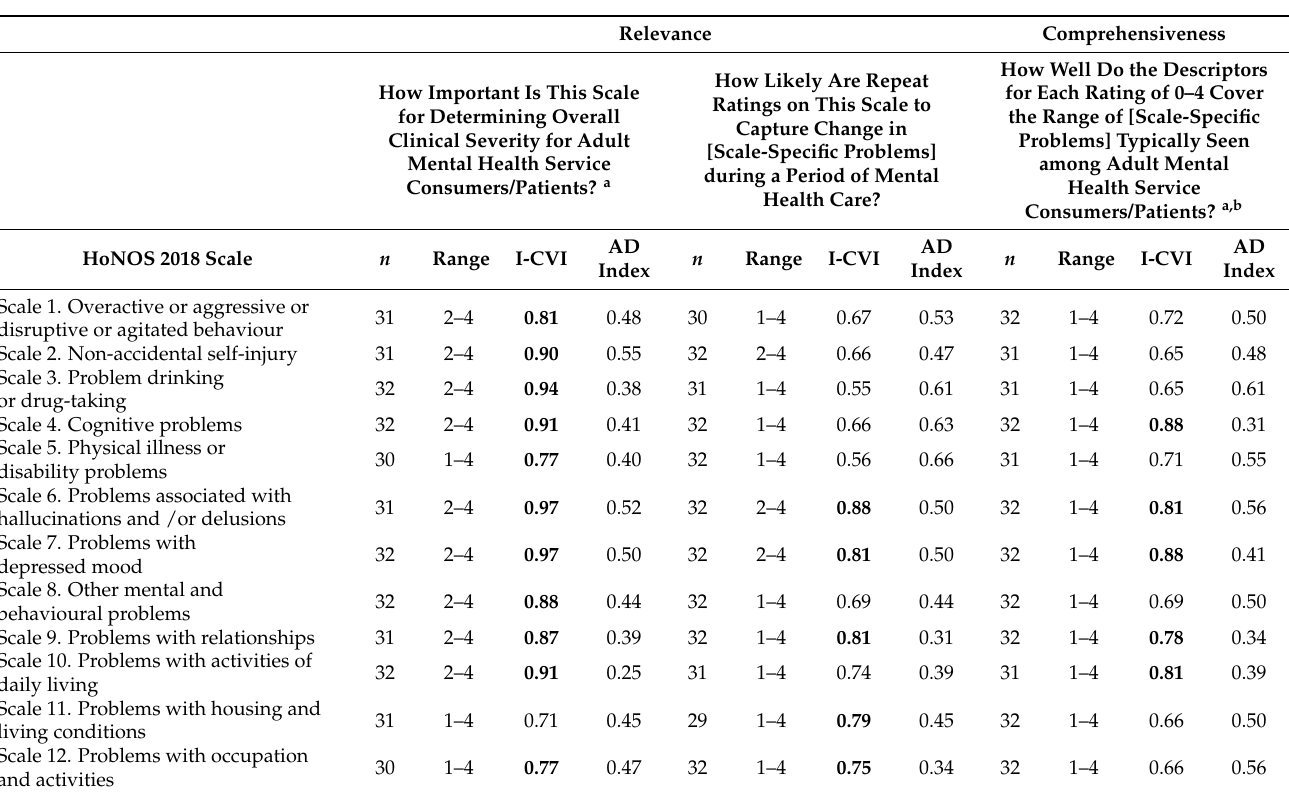
Table 3. Experts’ ratings of the content validity of the HoNOS 2018 scales: relevance and comprehen-